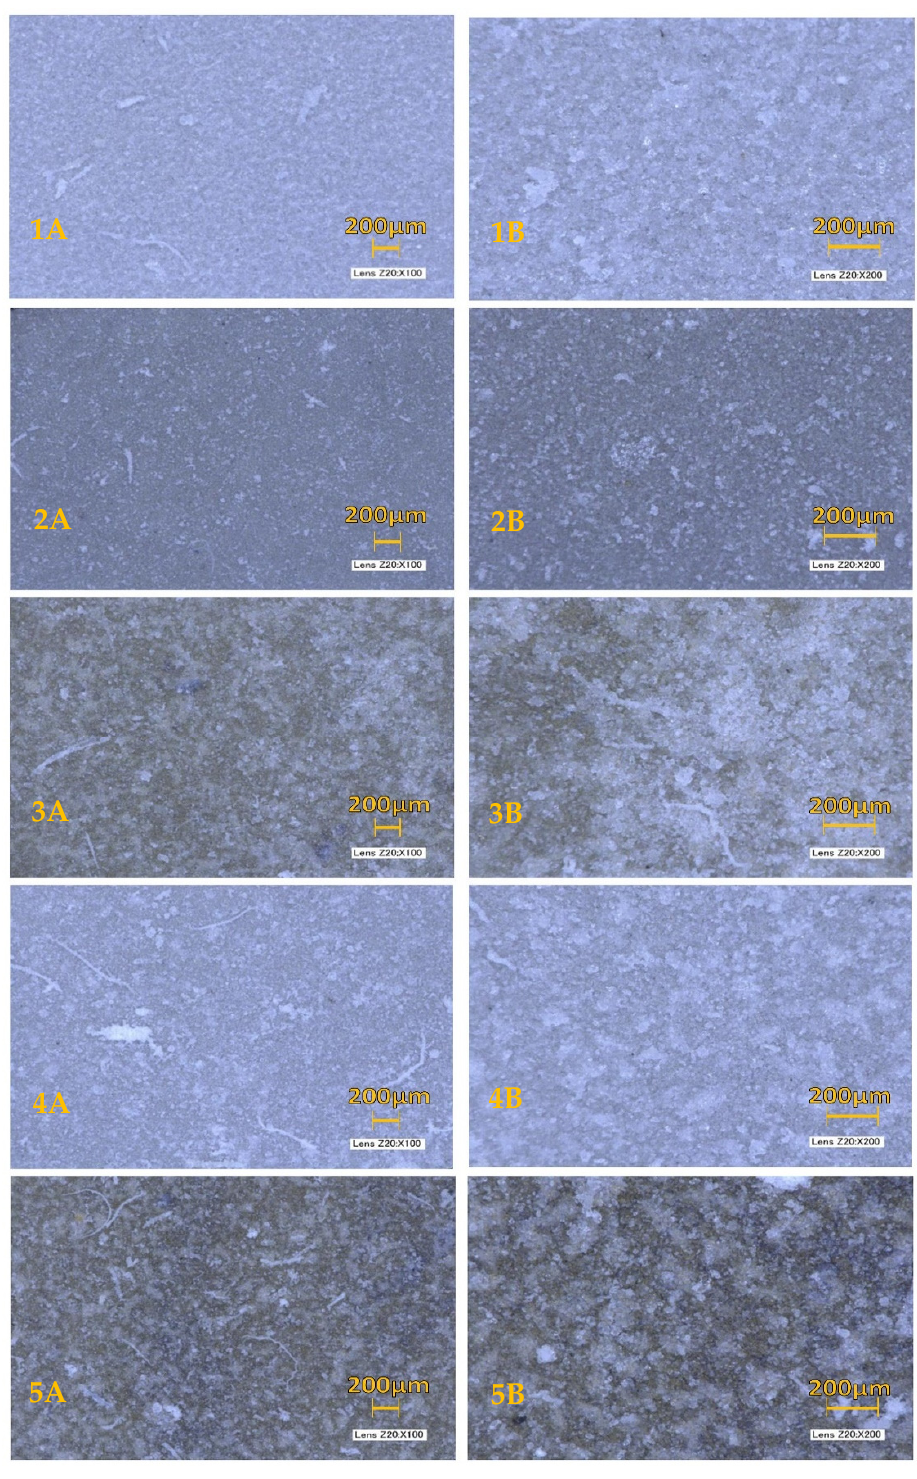
Figure 1. Optical Microscope HA Formation Comparisons. Magnification seen at 20 × 100 ( A ) and 20 × 200 ( B ): ( 1 ) control titanium; ( 2 ) sodium hydroxide coating; ( 3 ) quaternized titanium nitride coating; ( 4 ) silicon dioxide coating; ( 5 ) titanium nitride coating.